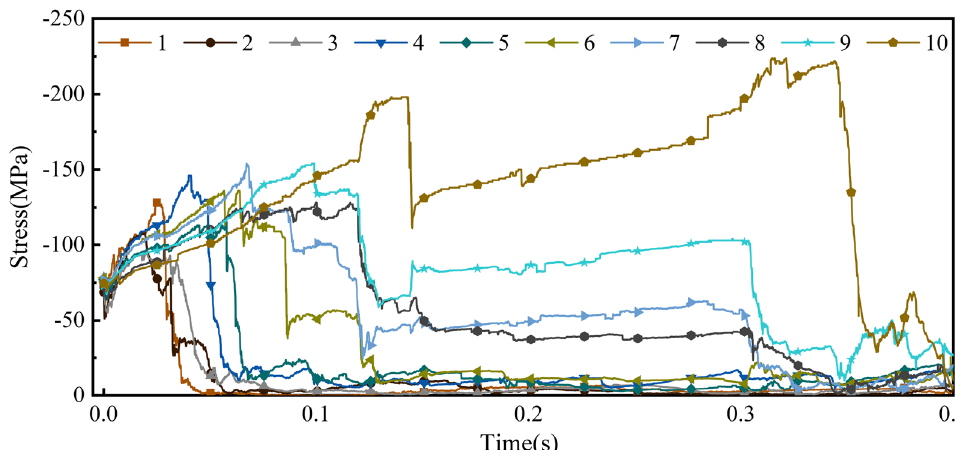
Fig. 11 Stress change diagram of the left